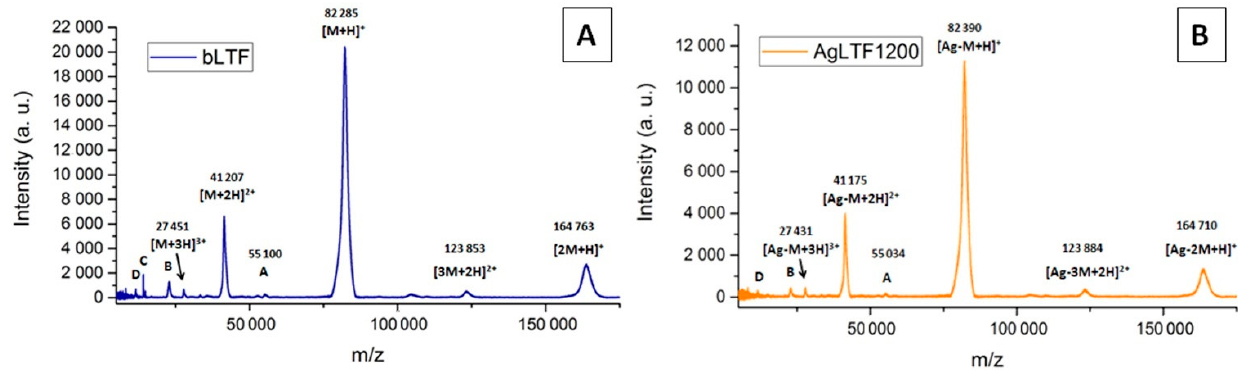
Figure 7. MALDI-TOF MS spectra of ( A ) native bLTF and ( B ) Fe-bLTF complex. After silver immobilization onto bLTF, the decrease in all signals’ intensity can be observed. The signal-intensity decrease is connected to their suppression by unbonded or loosely bonded Ag + . Some signals of impurities even become almost undistinguishable. To other effects, the signal shifts to higher m/z values can be noticed indicating the formation of silver adducts with protein. Moreover, some signals have shifted to lower m/z values, which may be connected to protein